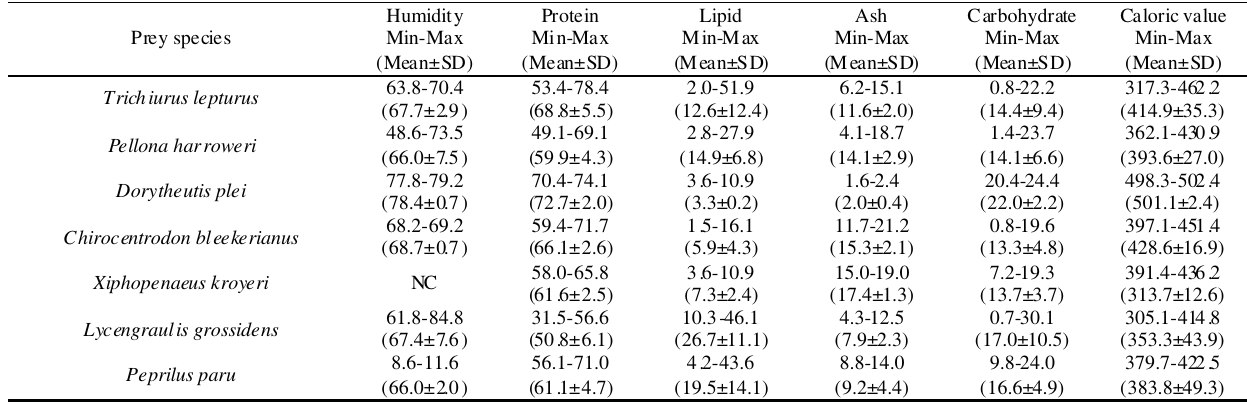
Table 2. Characterization of the prey species of Trichiurus lepturus in northern Rio de Janeiro State, Brazil, regarding